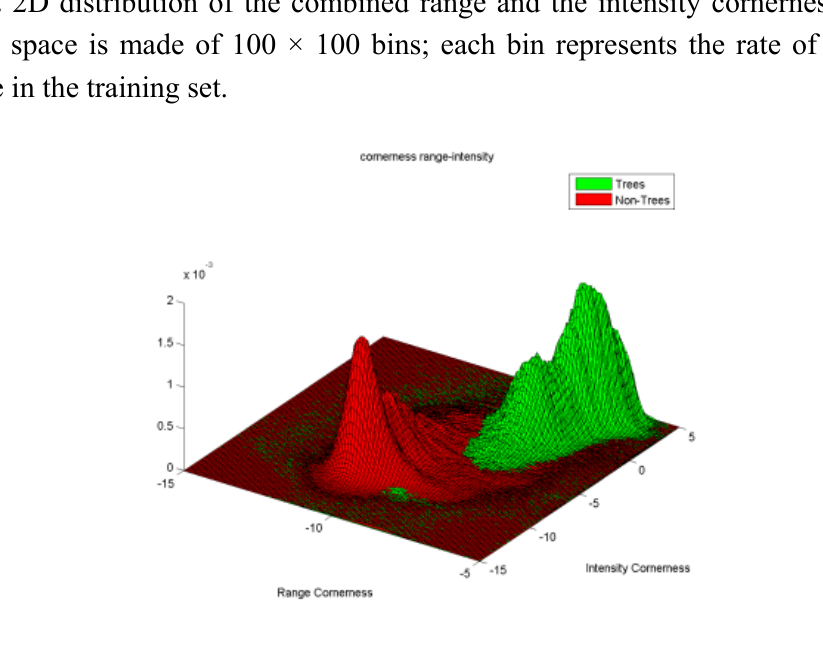
Figure 14. ( a ) 2D distribution of the combined u - v cues. ( b ) 2D distribution of the combined Hue and Saturation cues. The 2D feature space is made of 100x100 bins; each bin represents the rate of this cue set appearance in the training